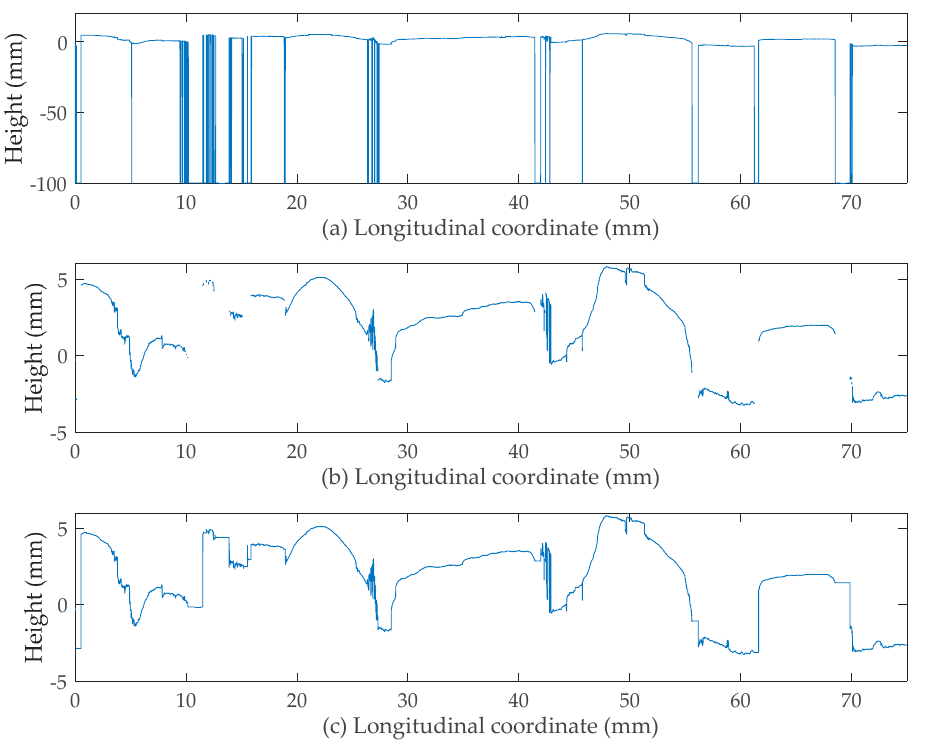
Figure 5. ( a ) Original measurements; ( b ) measurements with dropout value dismissed; ( c ) measurements with dropout